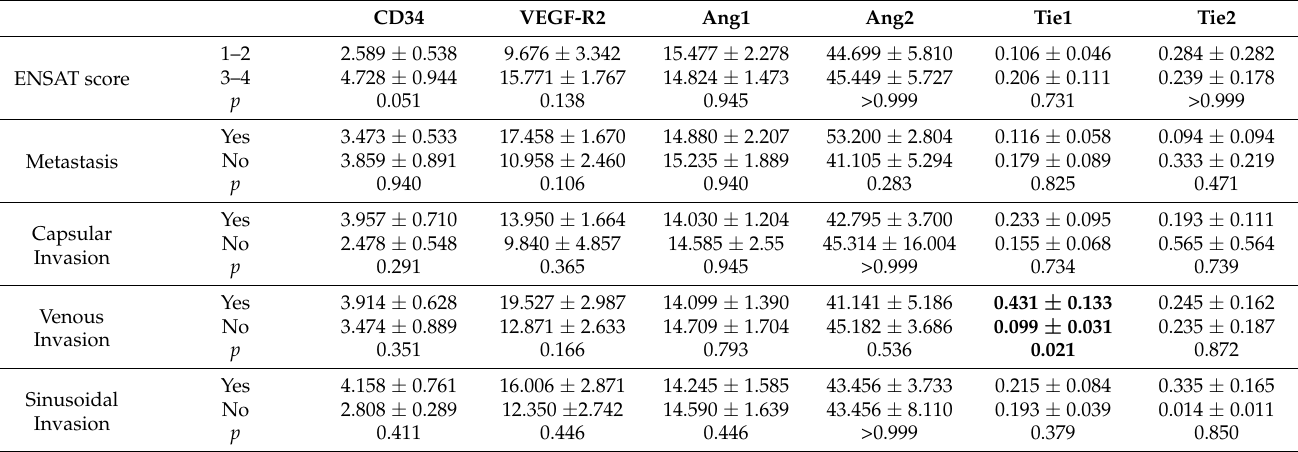
Table 2. Percentage of stained area of each angiogenic marker according to subgroup analysis ENSAT score, metastasis, capsular, venous and sinusoids invasion. CD34 VEGF-R2 Ang1 Ang2 Tie1 Tie2